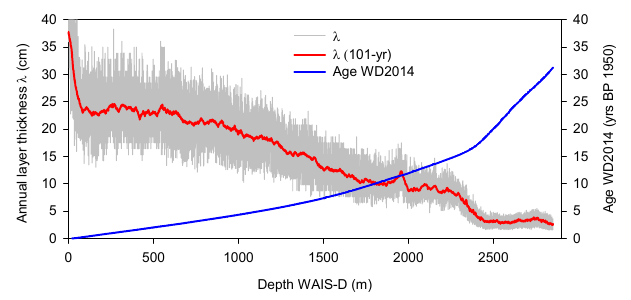
Figure 8. Depth–age profile for WAIS Divide and evolution of the annual-layer thickness ( λ ) for the annual-layer-dated part of the WD2014